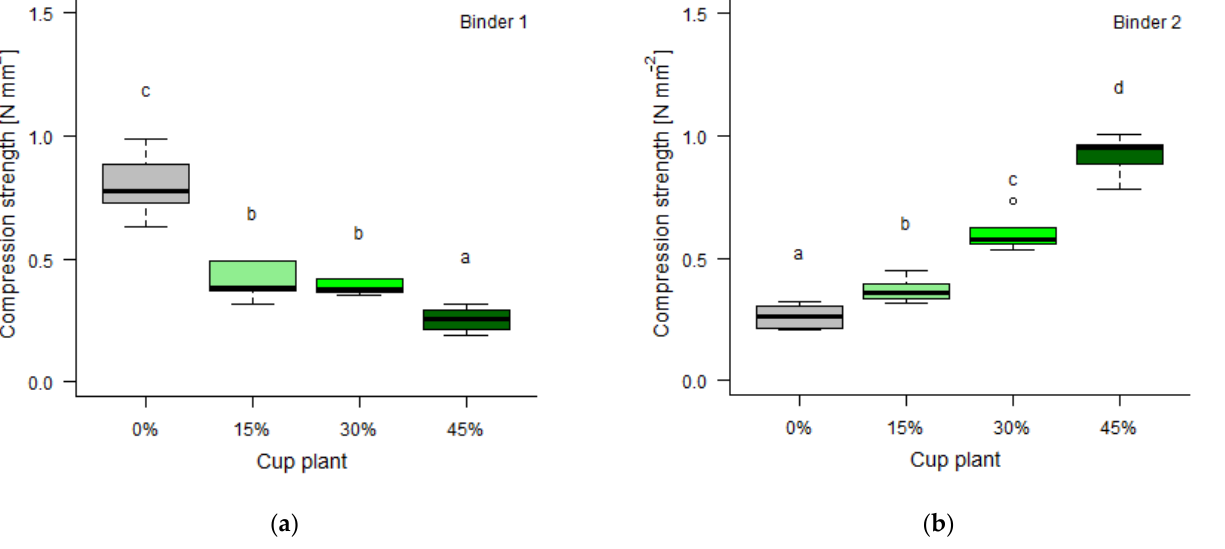
Figure 9. Compression strength values [N mm − 2 ] at 20% compression after 28 days. Samples with 0–45% cup plant mixed with Binder 1 ( a ) or Binder 2 ( b ). [The letters a–d represent homogeneous subsets of the 28 days strength averages according to Tukey HSD, n = 6].